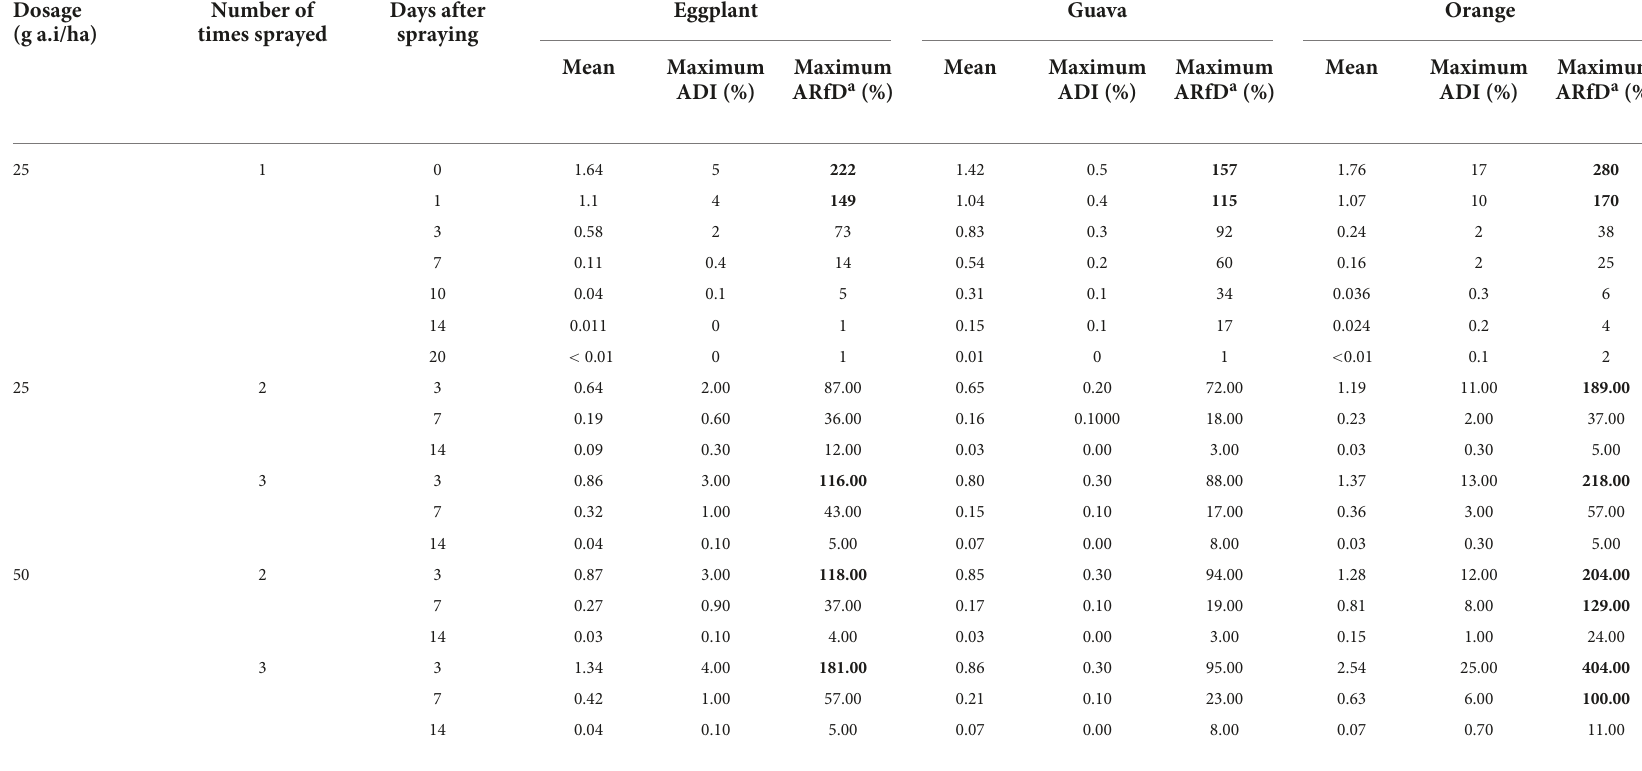
TABLE 7 Long-term and short-term exposure calculations of fenpyroximate in eggplant, guava, and orange fruits for the European consumer using the EFSA PRIMo revision 3. Dosage (g